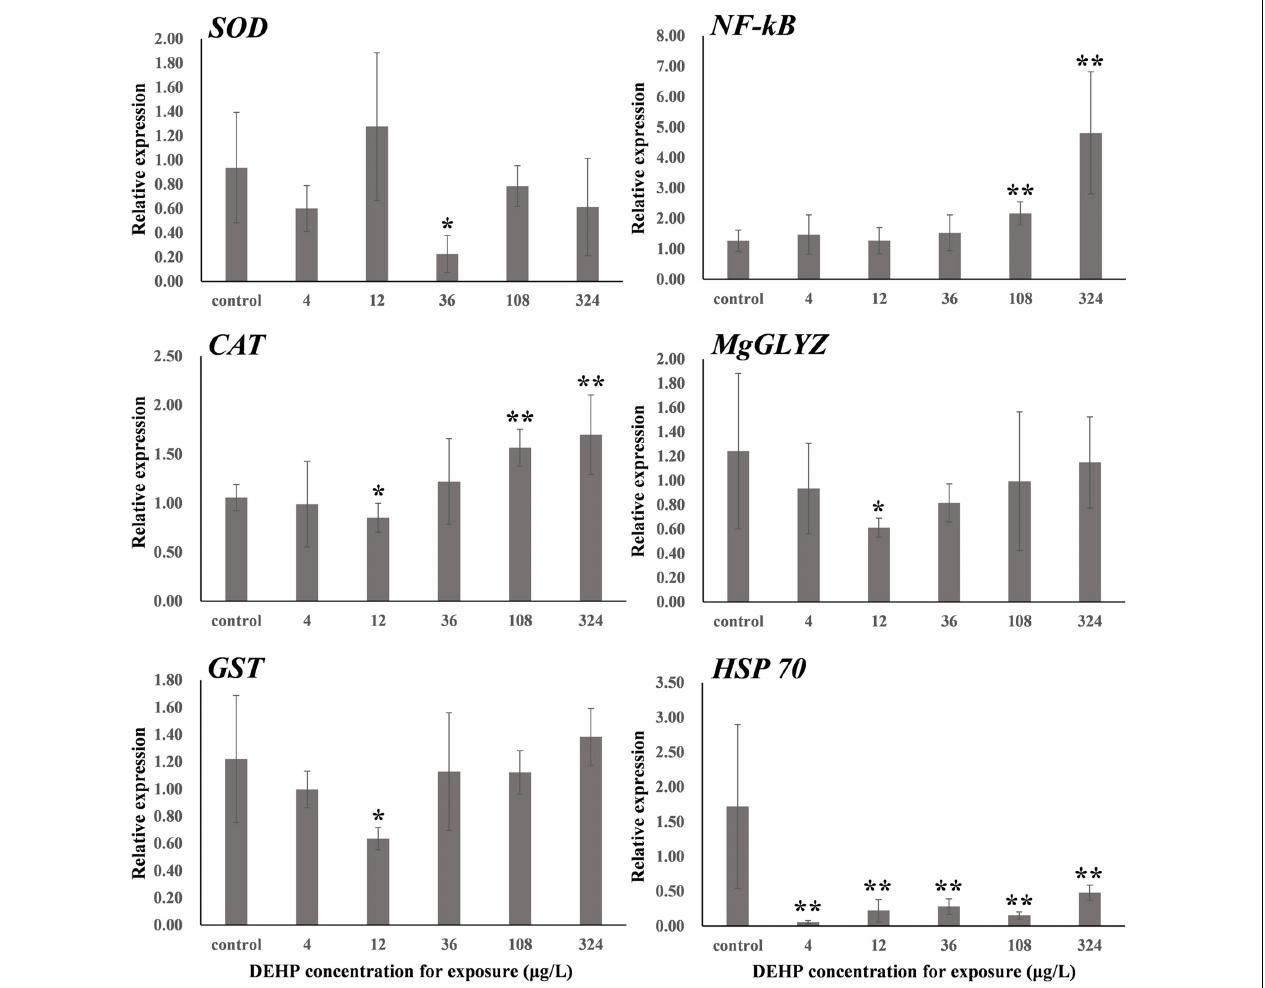
FIGURE 1 | In the study of SOD , CAT , GST , NF- κ B , MgGLYZ , and HSP70 in the samples from Mytilus galloprovincialis, the expression levels exhibited a significant difference relative to the negative controls. * P < 0.05. ** P < 0.01. CAT , catalase; GST , glutathione S-transferase; SOD , superoxide dismutase; NF- κ B , nuclear factor-k-gene binding; MgGLYZ , goose-type lysozymes in M. galloprovincialis ; HSP70 , heat shock protein